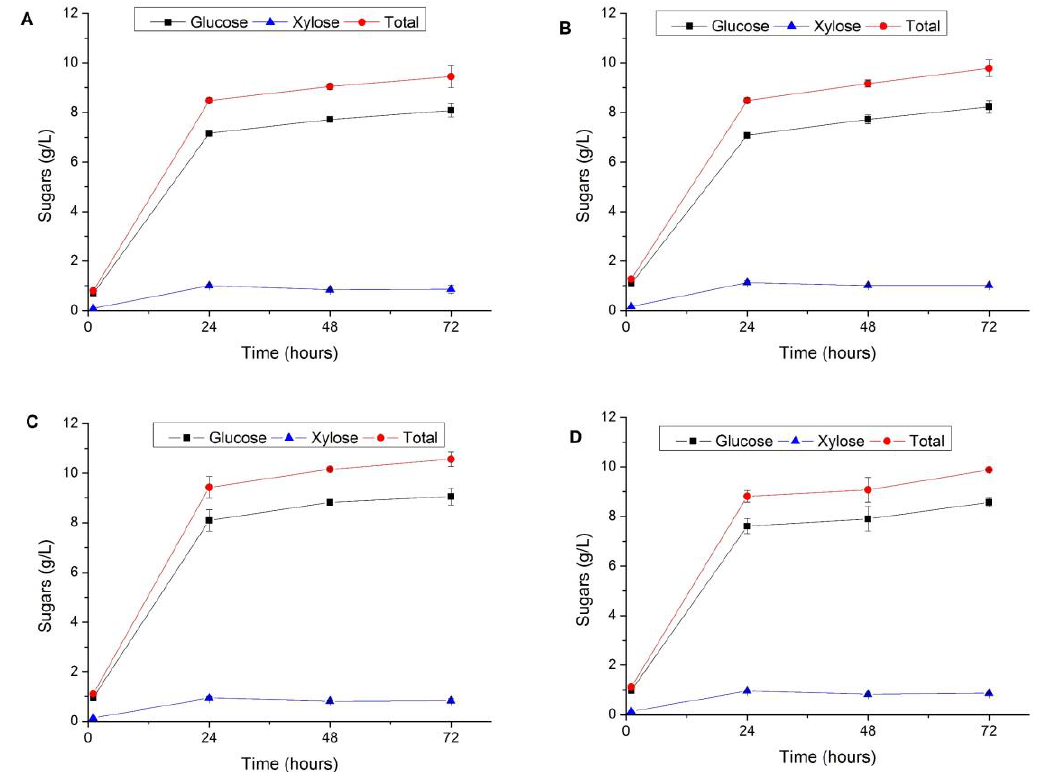
Figure 2. Sugar production by enzymatic hydrolysis of the water-insoluble solid (WIS) fractions collected after extrusion of vegetal tomato plant waste (VTPW). Enzymatic hydrolysis conditions: 50 °C, 5% ( w/v ) substrate loading, 15 FPU Cellic CTec2/g DW. ( A ) 6% NaOH ( w/w ), one-run: ( B ) 6% NaOH ( w/w ), three-run; ( C ) 12% NaOH ( w/w ), one-run; 12% NaOH ( w/w ), three-run. At the same time point, no statistically significant differences betwen any pair of means of sugar production were found for different extrusion treatment ( A – D ) at the 95.0% confidence level (one-way ANOVA with Bonferroni’s post-test was used for multiple comparison test, n = 3 ).